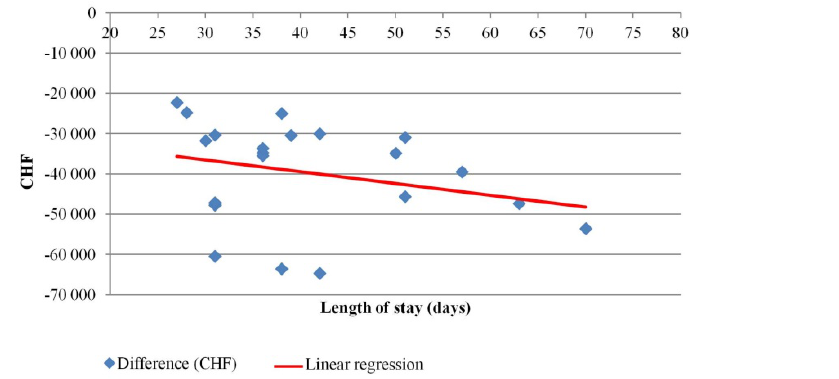
Figure 7. Difference between costs and revenues for each hospital stay.